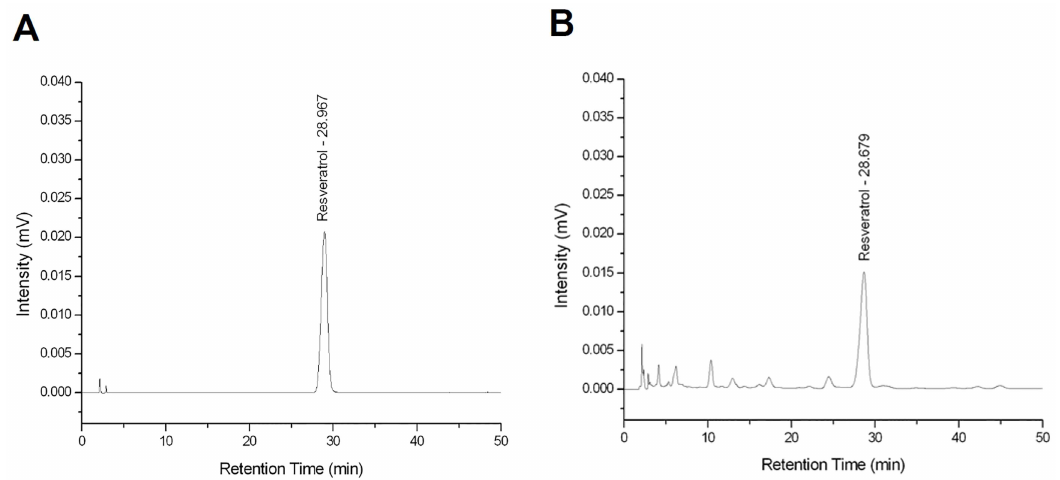
Fig 1. High-performanceliquid chromatography (HPLC) chromatograms of resveratrol (RV). The tested samples (A) standard RV samples, and (B) RV isolatedfrom peanutstem extract (PSE) of Arachis hypogaea .